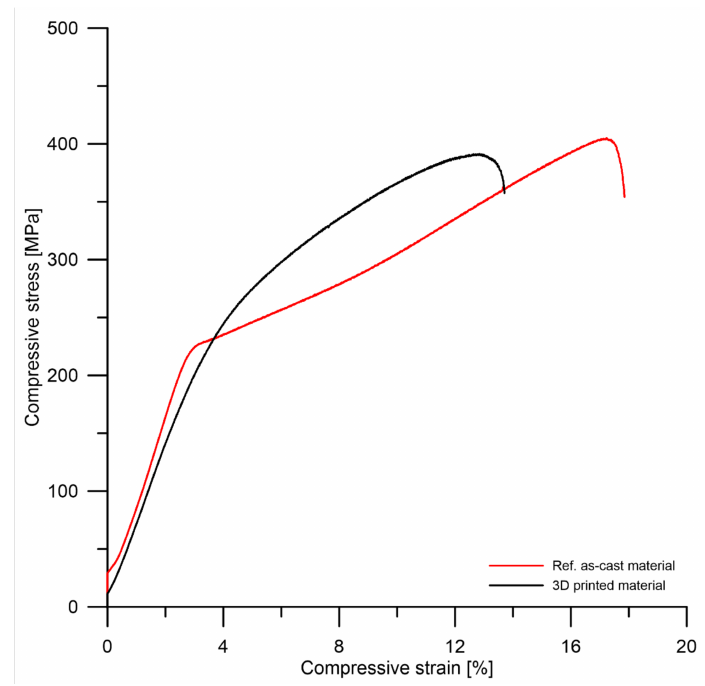
Figure 9. Compression stress–strain curves of tested